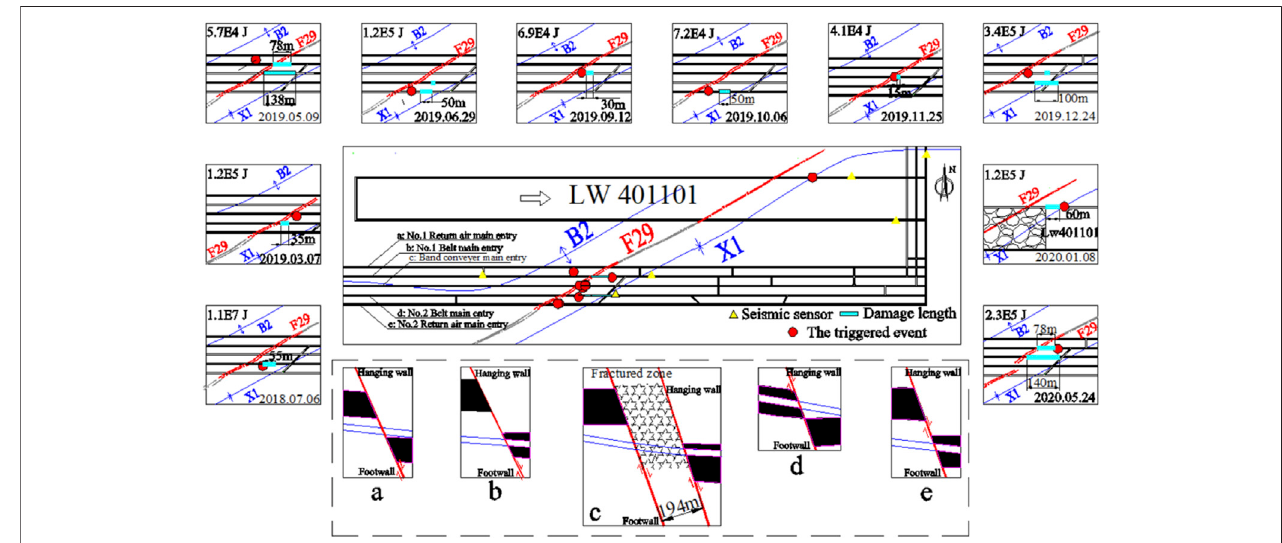
FIGURE 4 | Map of the locations of the previous bursts and the faults of each main